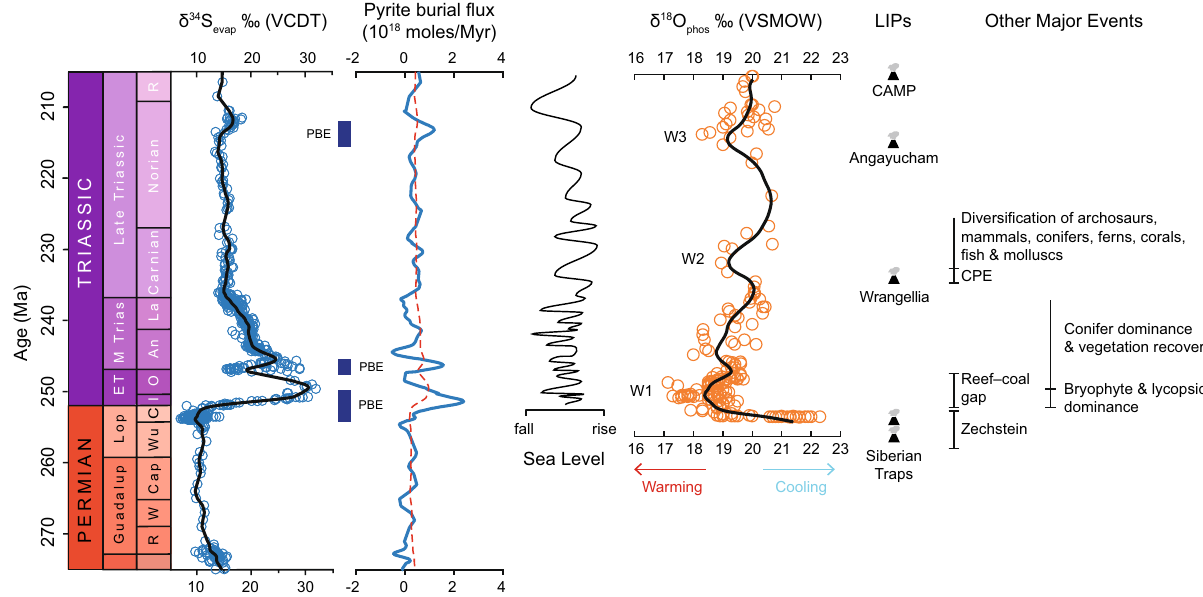
Figure 4. Sulphur and oxygen 8,18 isotope records, modelled pyrite burial flux (see Fig. 3a) and environmental and biological changes for the latest Permian and Triassic. The sulphur and oxygen isotope data were fitted with a smoothing spline to produce the curves. The pyrite burial flux was calculated with the use of a sulphur isotope box model 28 (see Supplementary). The predicted pyrite burial events are indicated with the abbreviation ‘PBE’. The blue line represents the calculated values, and the red dashed line illustrates the results assuming steady state. Environmental and biological events 43,44 of significance are included to display how our isotope records and model outputs relate to the broader environmental context of the latest Permian and